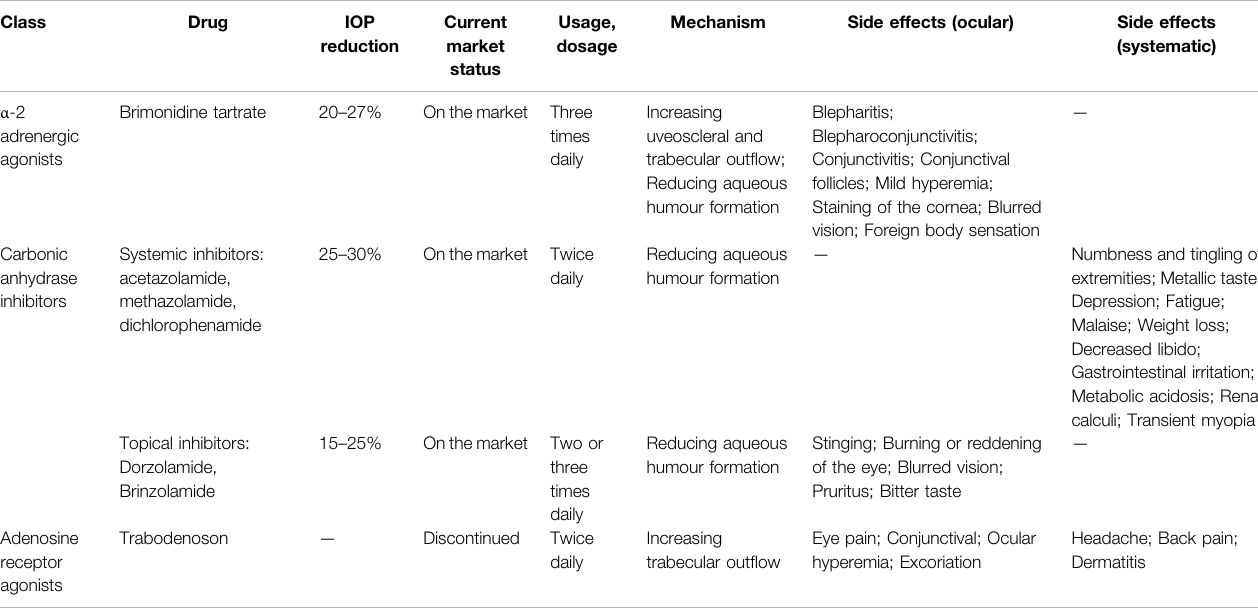
TABLE 4 | The class and list of other topical glaucoma